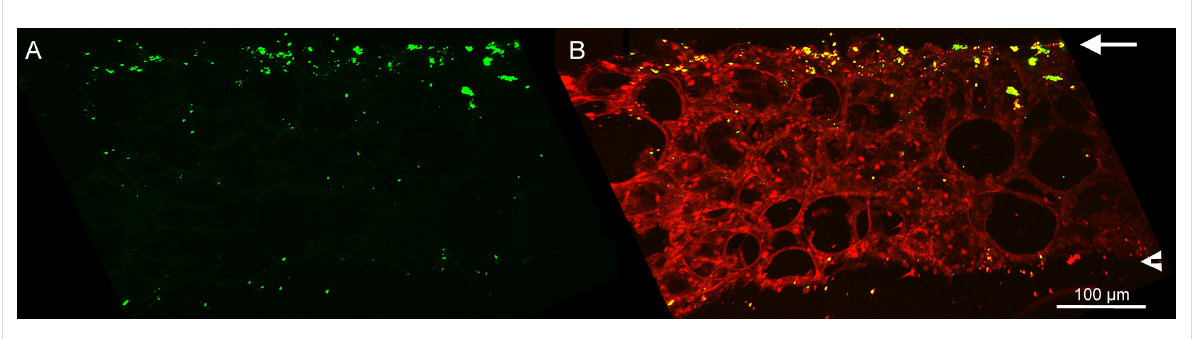
Figure 7: Multiphoton microscopy of Ag-NPs in the lung tissue. Image of an 80 µm median cryosection of PCLS incubated for 24 h with Ag-NPs (30 µg/mL). Red: signal of lung tissue; green: signal of Ag-NPs aggregates/agglomerates. A: green signal; B: merge of red and green signal. The arrows mark the upper cut surface, the arrow heads the lower cut